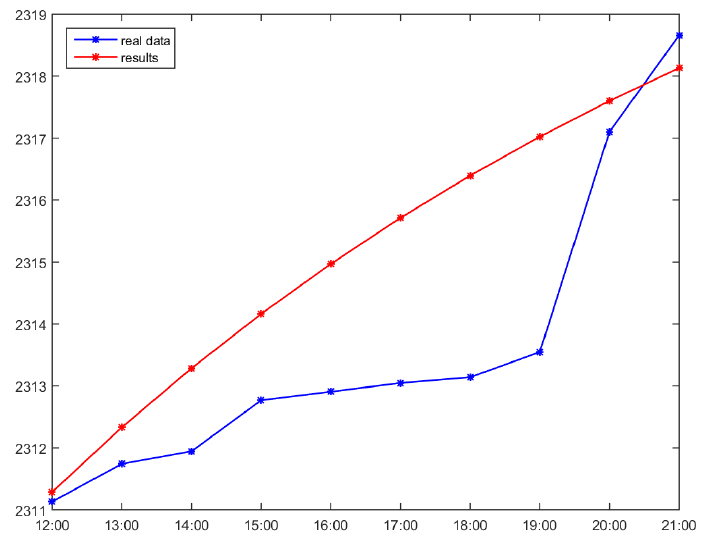
Figure 9. Comparison between the real data and ARIMA-based compensation results.